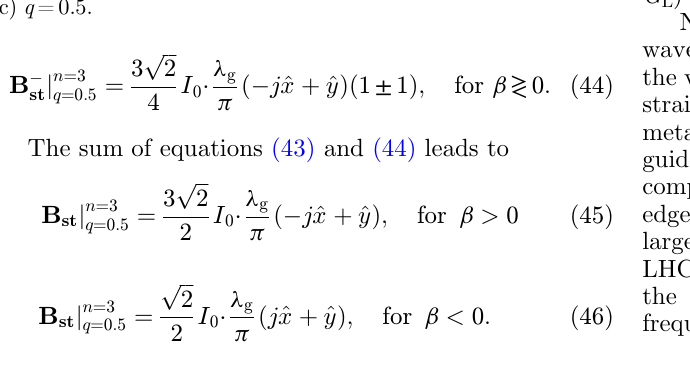
Fig. 23. E BrdSQ j n q ¼ E for square model-N. (a) q =0. (b) q =1. (c) q =0.5.